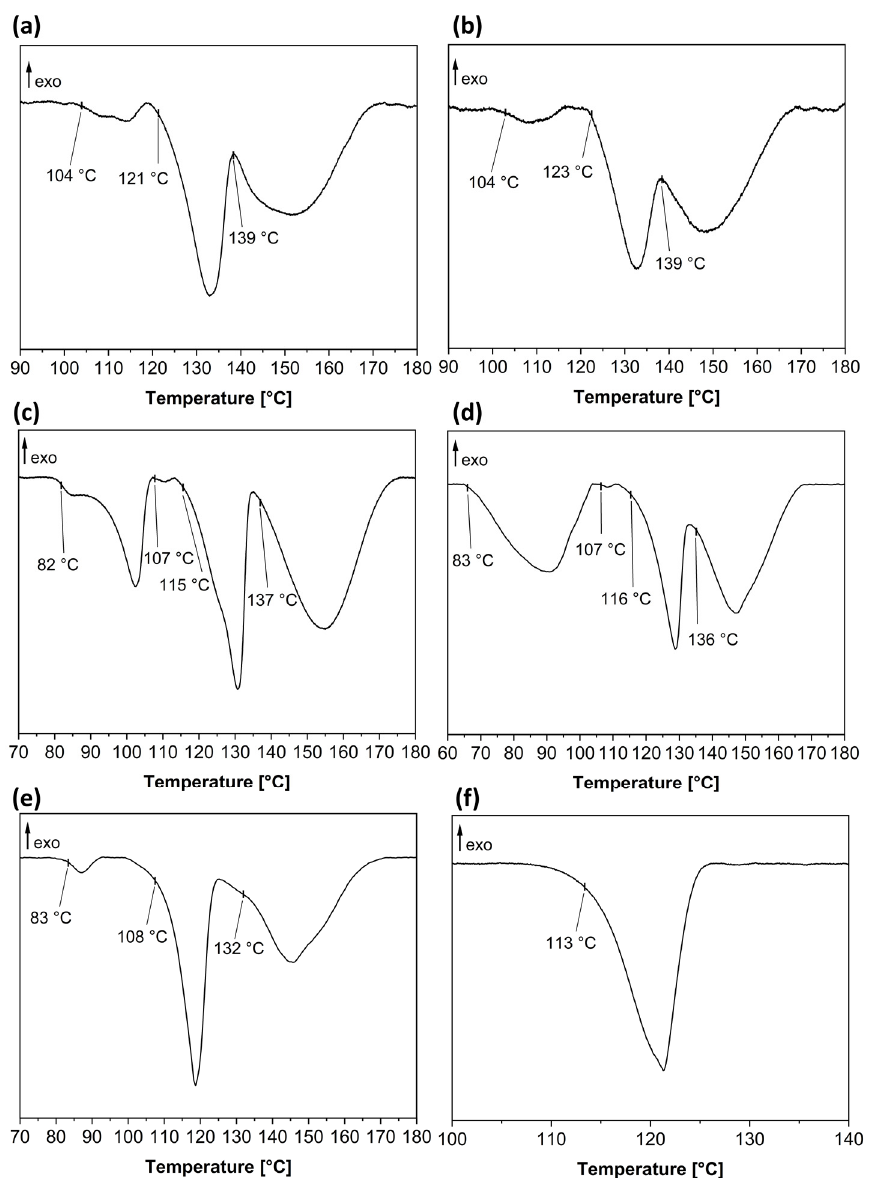
Figure 12. DSC data collected from samples grown from aqueous solution ( a ) Phenibut:D − malic acid, ( b ) Phenibut:L − malic acid, ( e ) Phenibut:DL − malic acid and samples obtained by milling ( c ) Phenibut:D − malic acid, ( d ) Phenibut:L − malic acid and ( f ) Phenibut:DL − malic acid. DSC